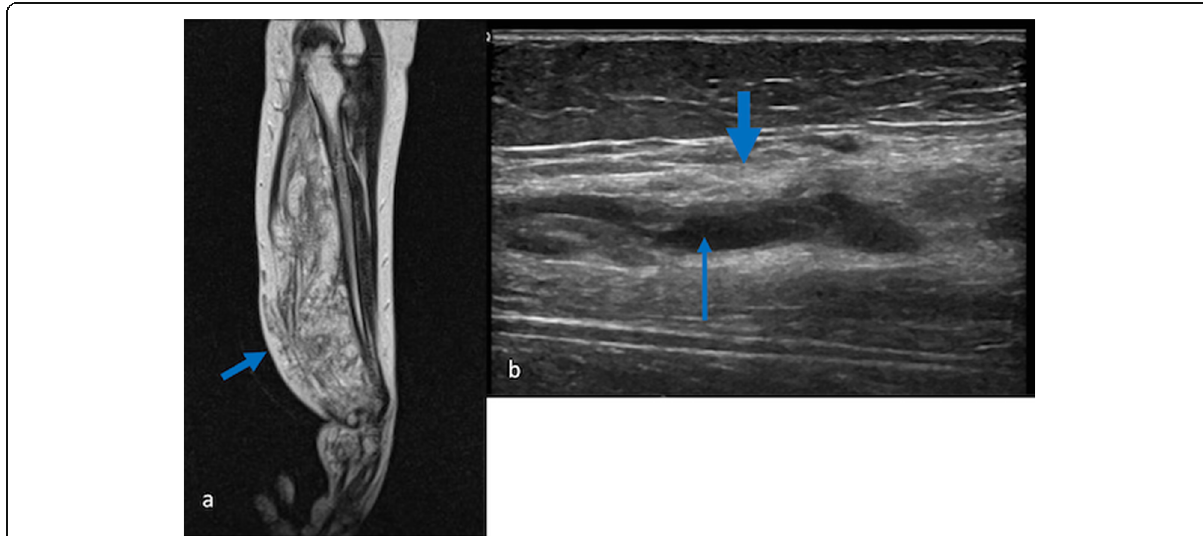
Fig. 12 a sagittal T1 weighted MR image of the forearm in a 12 year old female. The FAVA lesion (short arrow) replaces almost all of the flexor compartment and is causing contracture at the wrist; b US image of a FAVA lesion of the calf, showing marked echogenicity of the affected muscle (thick arrow) and central dysplastic veins (thin